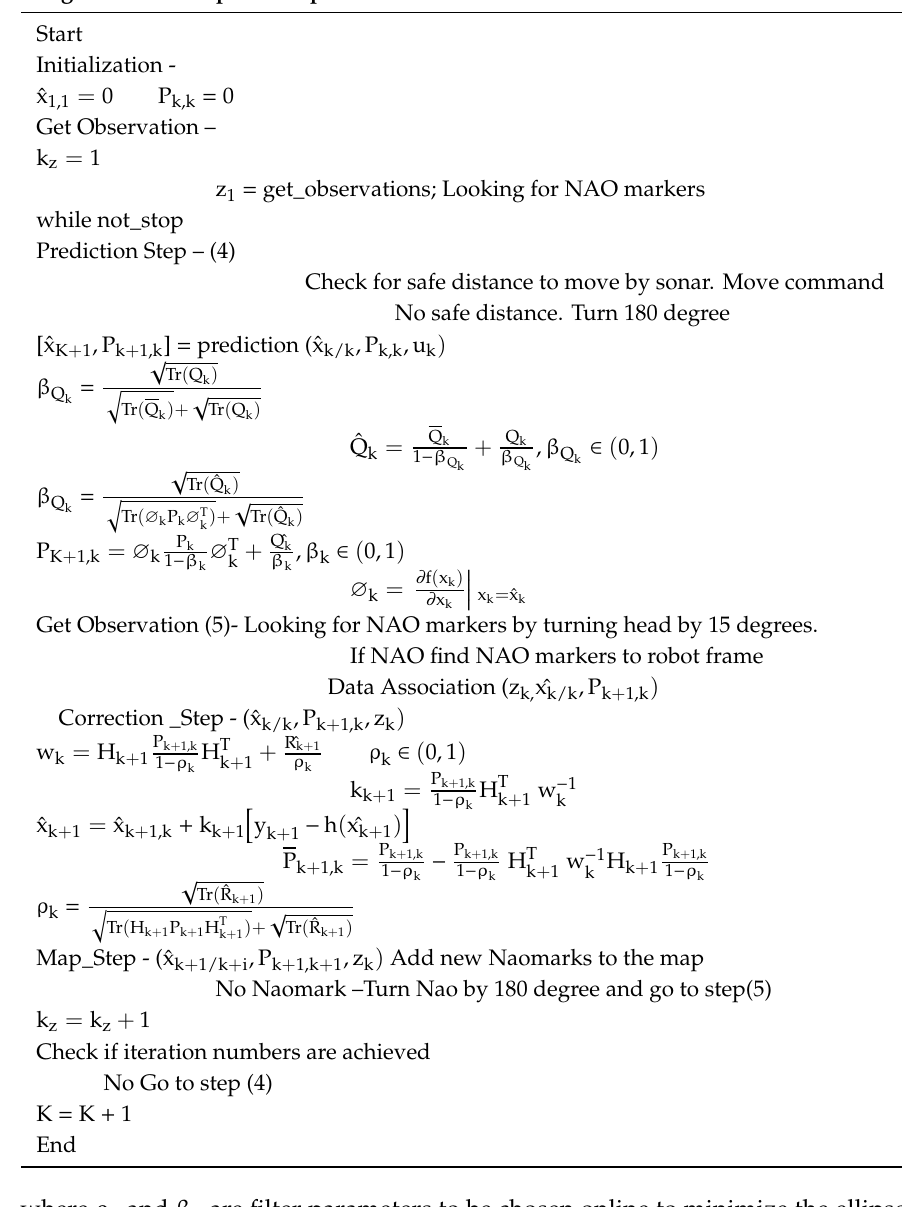
Algorithm 1. Adaptive Ellipsoidal